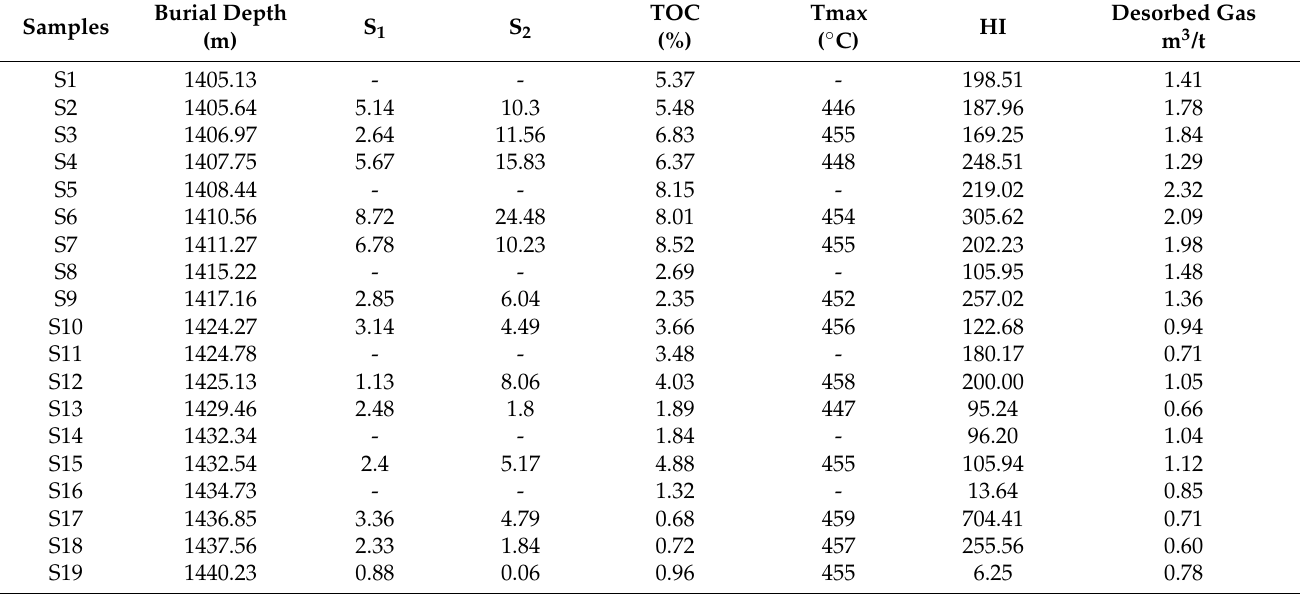
Table 1. Basic parameters of shale